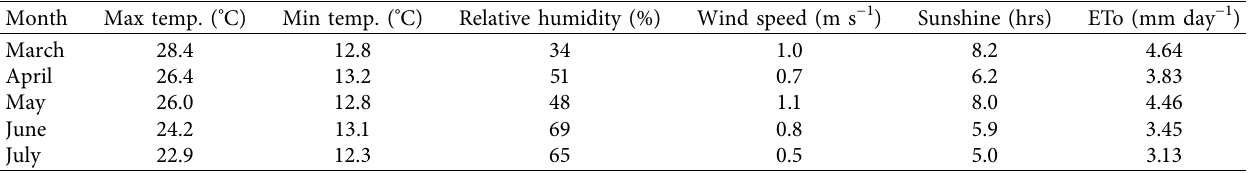
Table 2: Weather variables and reference evapotranspiration of wheat in the study area during March–July 2019. Month Max temp. ( ° C) Min temp. ( ° C) Relative humidity (%)